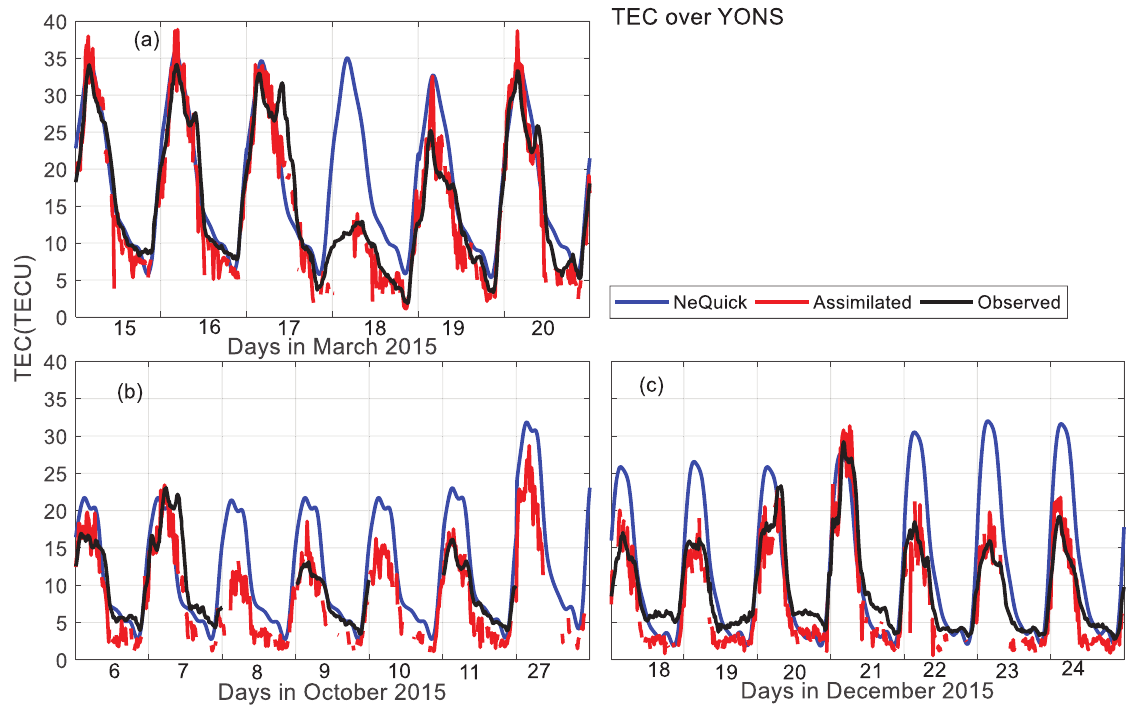
Figure 7. Panels (a) – (c) present TEC obtained from NeQuick model (blue), assimilation (red), and observed by ground-based GPS receiver (black) during March 15 – 20, October 6 – 11, 27, and December 18 – 24, 2015, respectively over